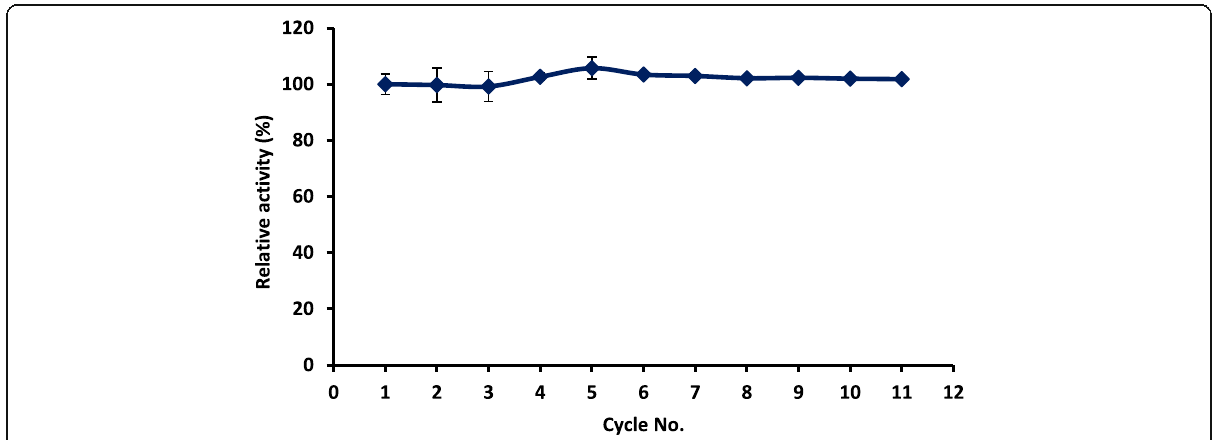
Fig. 11 Operational stability of immobilized glucoamylase